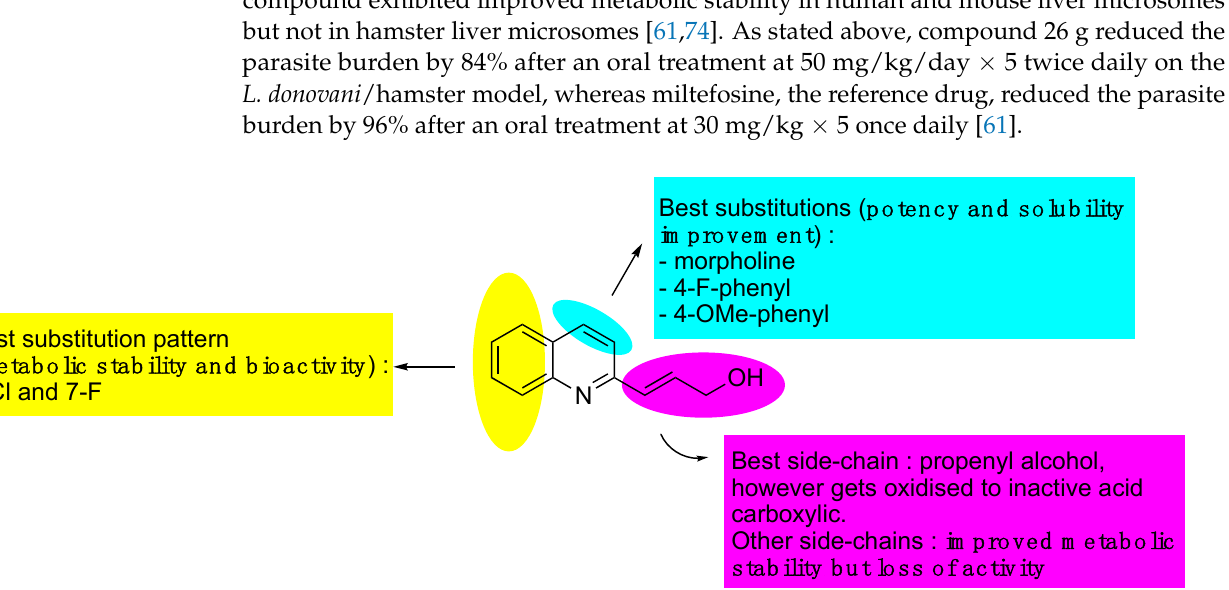
Figure 6. Structure–activity relationships of the 2-substituted quinolines.